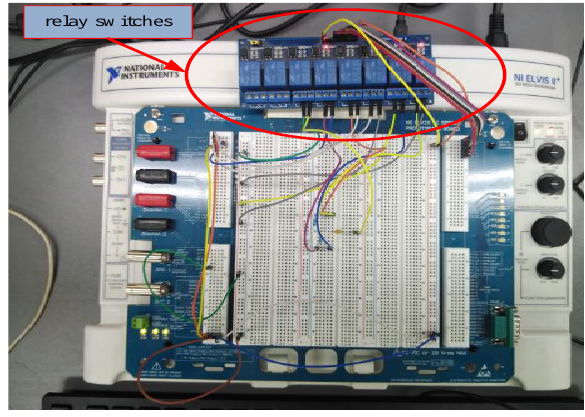
Figure 1. NI ELVIS II+ board with relay switches.